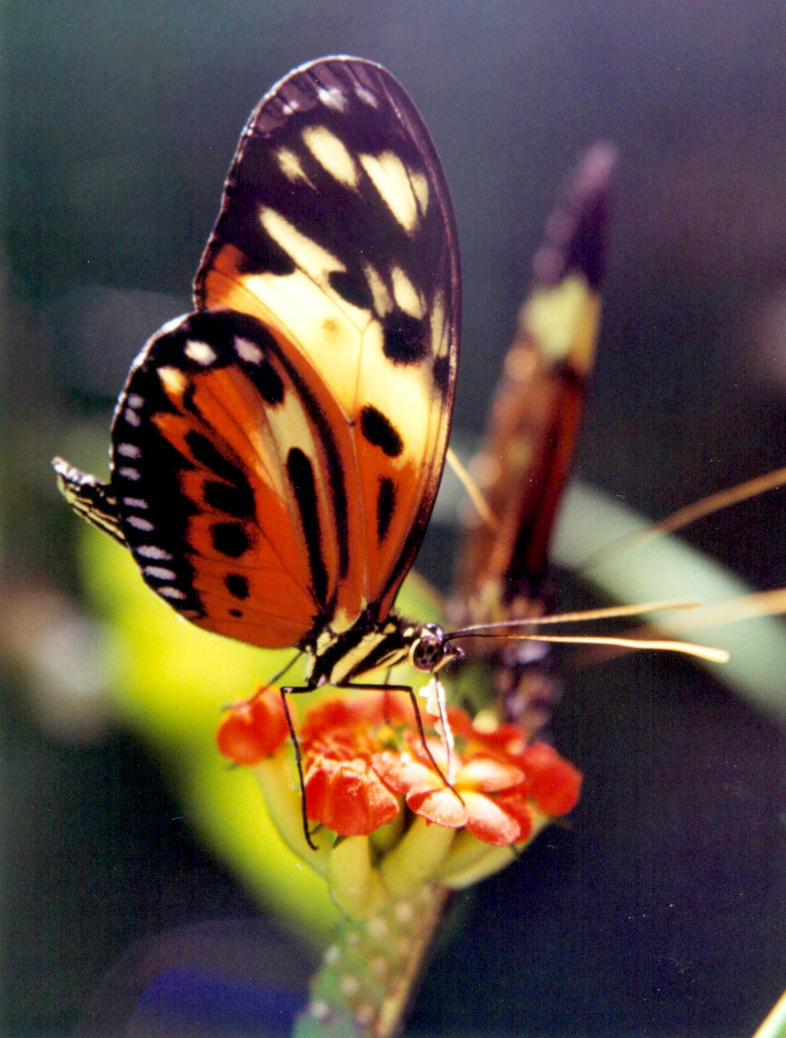

Heliconius numata, f. silvana feeding from a Psiguria flower. (Photo: Mathieu Joron)